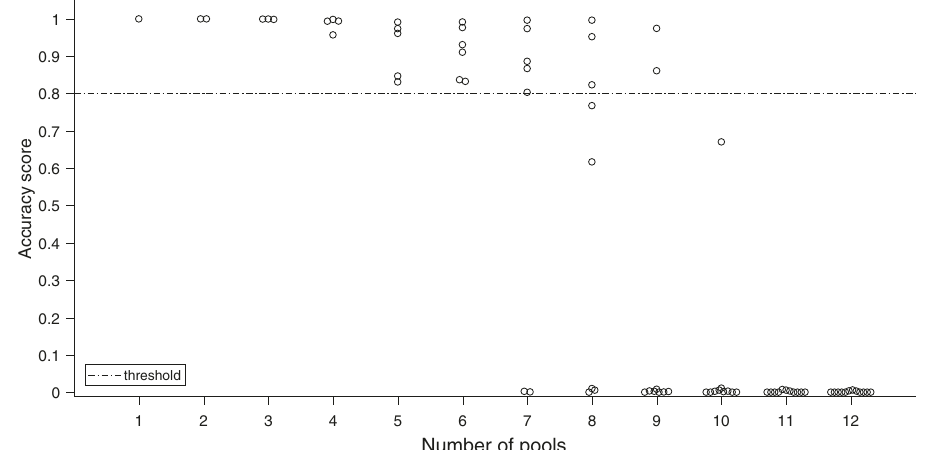
Fig. 9 Accuracy scores of one "standard" condition simulation, Related to Fig. 6. Units with accuracy score> 0.8 were counted